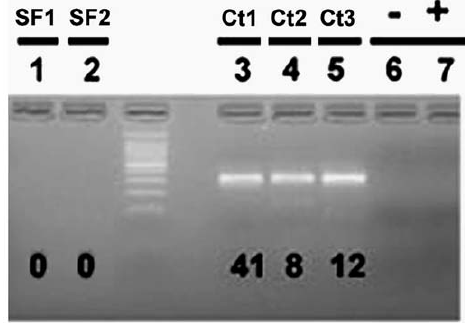
Figure 3. Amplification characteristics of the Rr- b -TUB qPCR primers under standard PCR conditions on metagenomic DNA isolated directly from soil collected at the South Farm (SF) and cotton (Ct) sites. The number of nematodes whose DNA was isolated is provided below the amplicon in each reaction. Rr- b -TUB primed reactions. Lane 1, SF1; Lane 2, SF2; Lane 3, Ct1 sample 1; Lane 4, Ct2 sample 2; Lane 5, Ct3 sample 3; Lane 6, No DNA; Lane 7, No Primers.